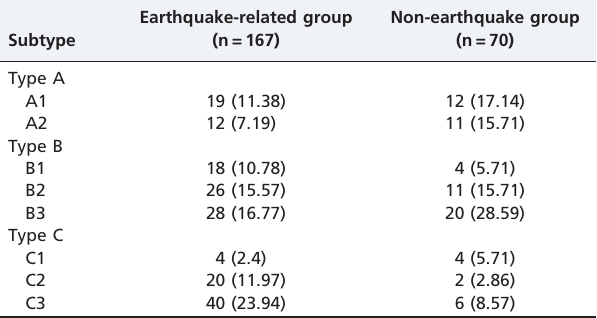
Table 5 - Patients with pelvic ring fractures according to each